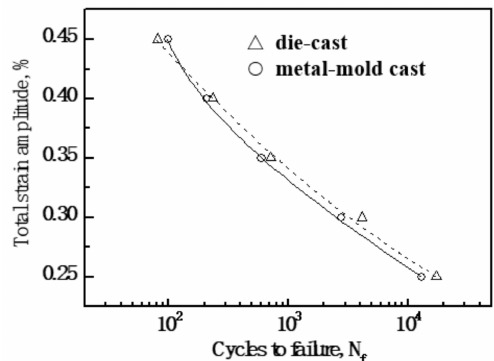
Figure 5. Total strain amplitude versus fatigue life for metal-mold cast and die cast Al-9Si-4Cu -0.4Mg-0.3Sc alloys.